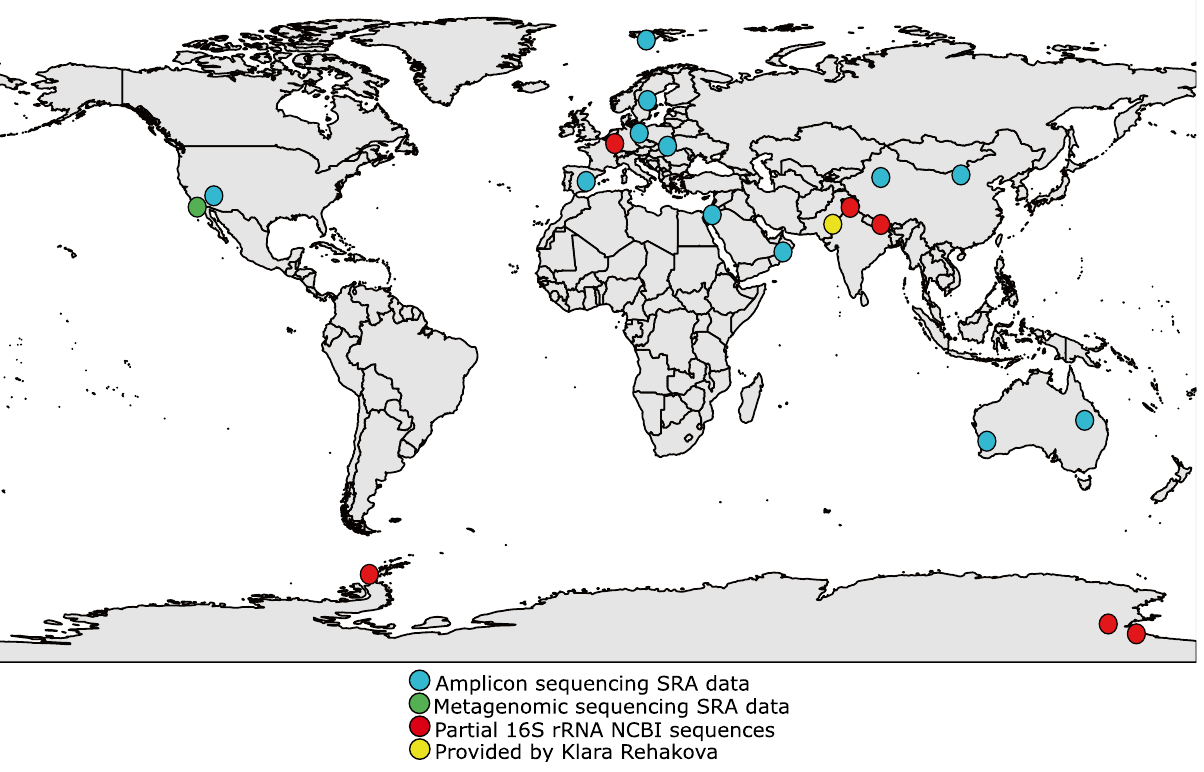
Figure 14. Geographical distribution of Argonema genus based on metagenomic data. The map was constructed using R software (www.R- proje ct. org), with packages rnaturalearth v0.1.0 (http:// github. com/ ropen scila bs/ rnatu ralea rth) and ggplot2 v.3.3.5 (https:// ggplo t2. tidyv erse. org), and modified in Inkscape (http:// www. inksc ape.